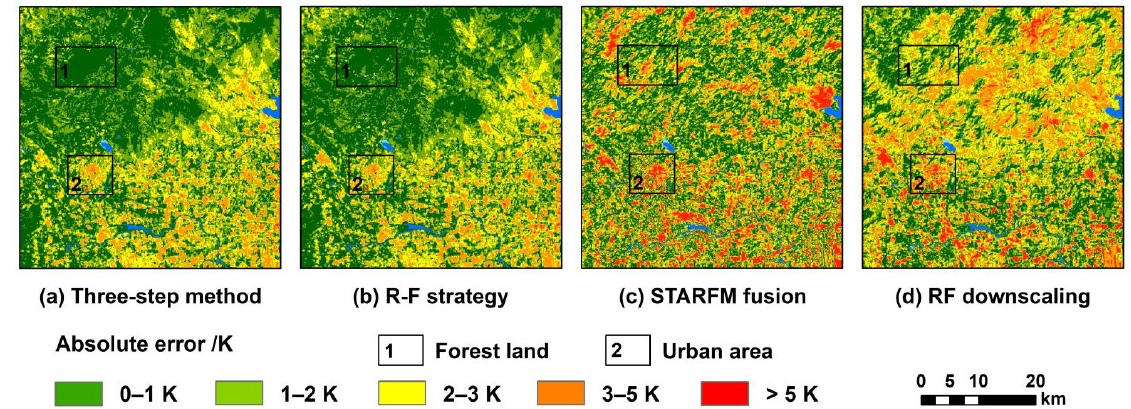
Figure 9. Distribution error maps of four predicted LST images for Image B1: ( a ) the three-step method, ( b ) the RF strategy, ( c ) the STARFM fusion, and ( d ) the RF downscaling.